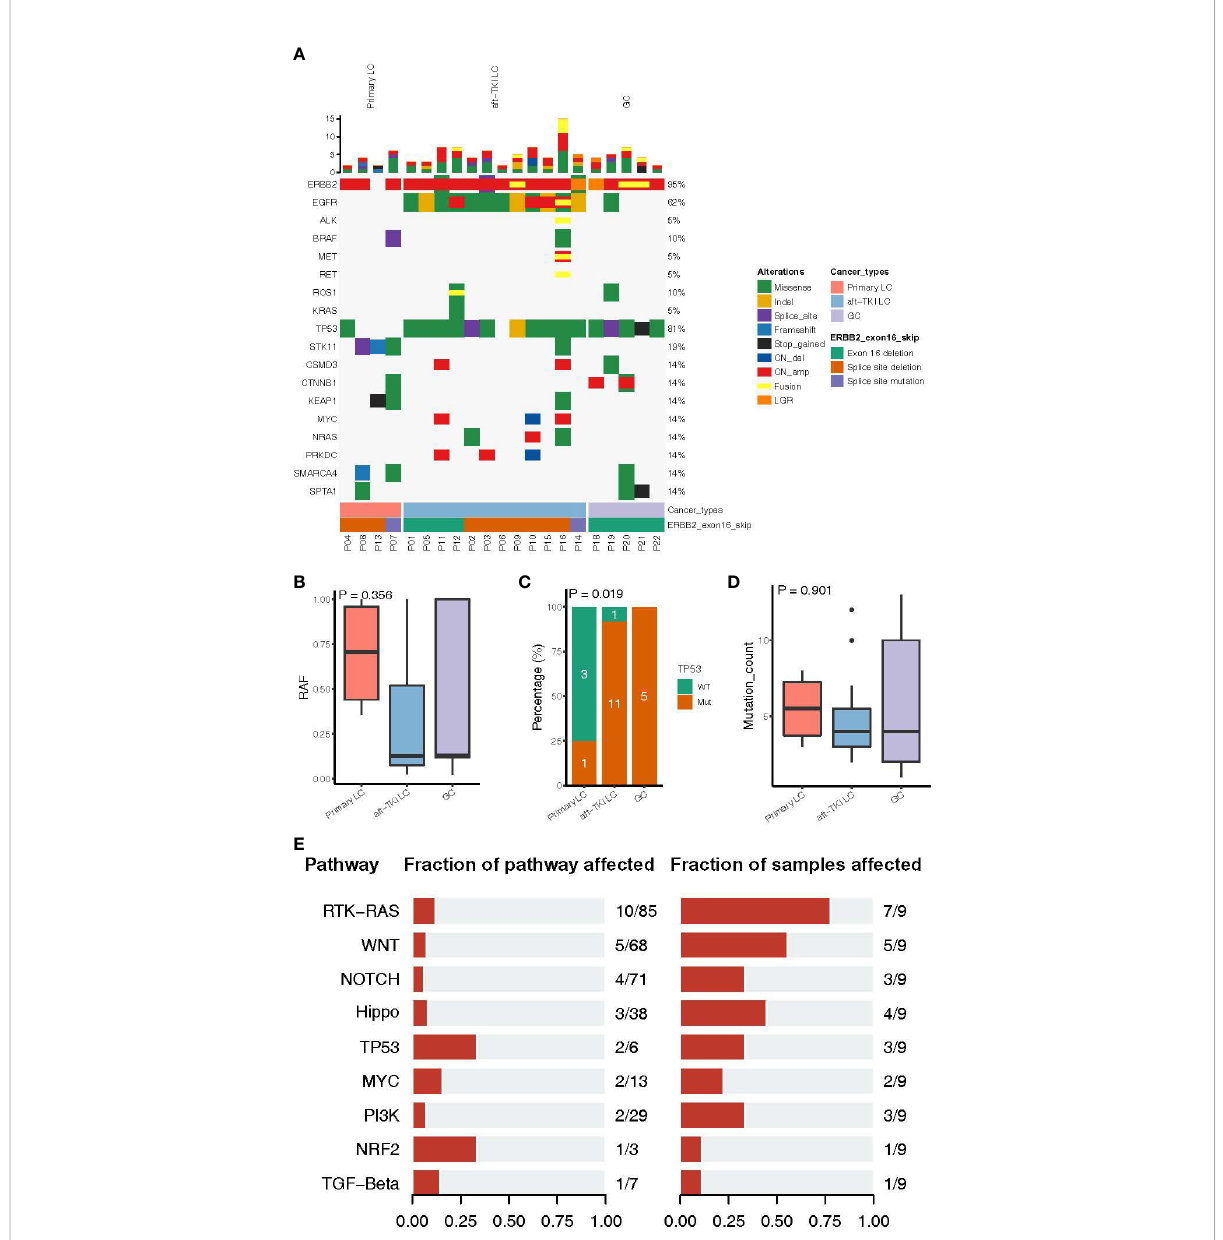
FIGURE 2 Molecular characteristics of patients harboring ERBB2 exon 16 skipping ( ERBB2 D Ex16). (A) An oncoprint of somatic mutation landscape of ERBB2 D Ex16+ patients from Cohort 1. Each row represents a gene indicated on the left, with the mutation rate indicated on the right. Each column represents a patient. Different colors denote the mutation types. Bar plots on top of the oncoprint summarize the number of mutations each patient carries. The cancer type, ERBB2 D Ex16 variant type, and patient ID of each patient were indicated by various colors at the bottom. (B) Relative allele frequency (RAF), (C) mutation frequencies of TP53 , and (D) number of somatic mutations in lung cancer (LC) patients before systemic therapy, LC patients after progression on EGFR tyrosine kinase inhibitors (TKIs), and in gastric cancer (GC) patients. (E) Genomic alterations harbored by ERBB2 D Ex16+ patients from TCGA were categorized by pathway and analyzed for the proportion of mutated among all pathway-related genes and the corresponding mutation frequency in patients. Number pairs in the middle (e.g. “ 10/85 ” for the RTK-RAS pathway), indicate the number of genes encoding for members of the indicated pathway that were found altered in ERBB2 D Ex16+ patients and number of genes encoding for members of the pathway, respectively. Number pairs at the rightmost (e.g. “ 7/9 ” for the RTK-RAS pathway), indicate the number of ERBB2 D Ex16+ patients carrying ≥ 1 alteration in genes in the indicated pathway and the number of ERBB2 D Ex16+ patients,